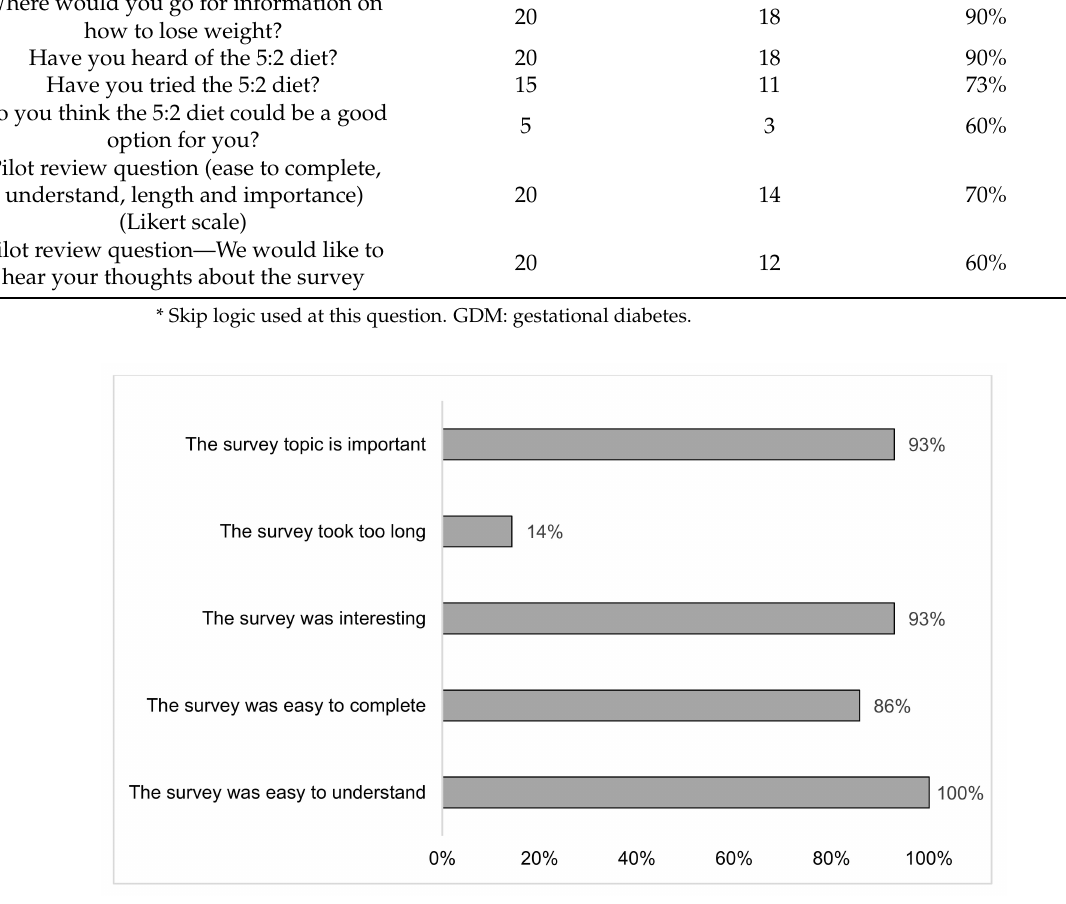
Figure 1. Pilot test review. Percentage of responders who agreed or strongly agreed on the Likert-scale survey review questions ( n = 14); responses were received on a five-point Likert-scale (1 = strongly disagree, 2 = disagree, 3 = not sure, 4 = agree, 5 = strongly